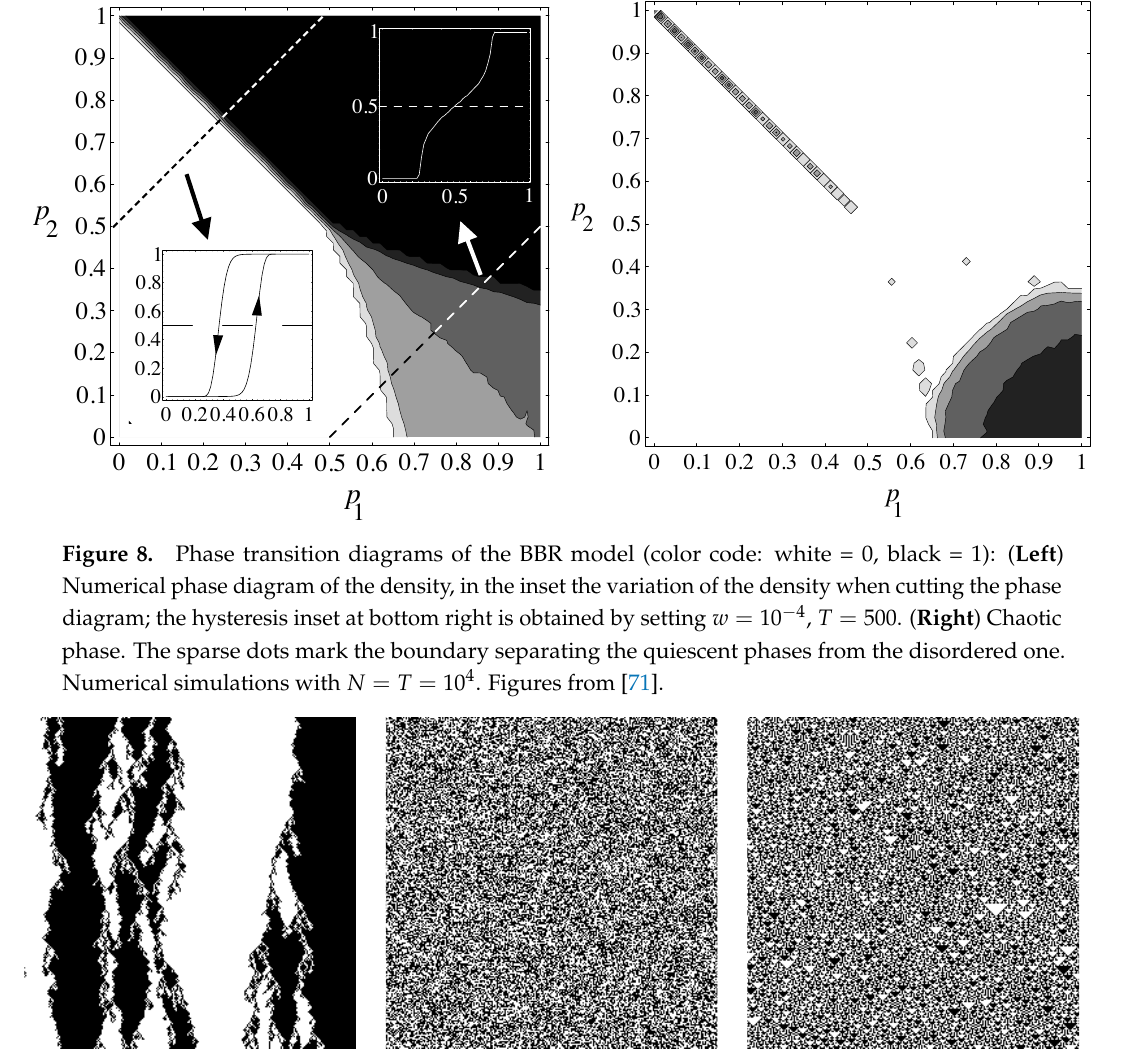
p 1 ) with N = T = 256. Time −